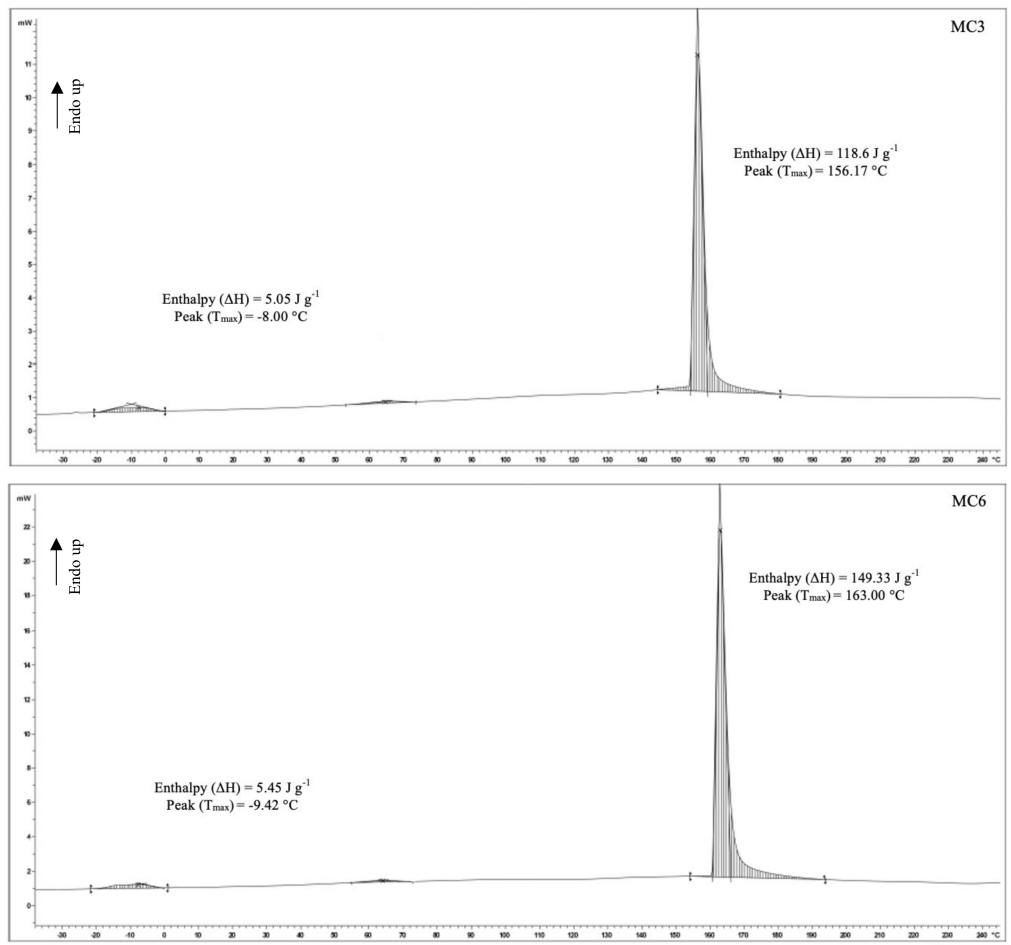
Figure 3. DSC thermograms of MC3 and MC6 (for Captions, see Figure